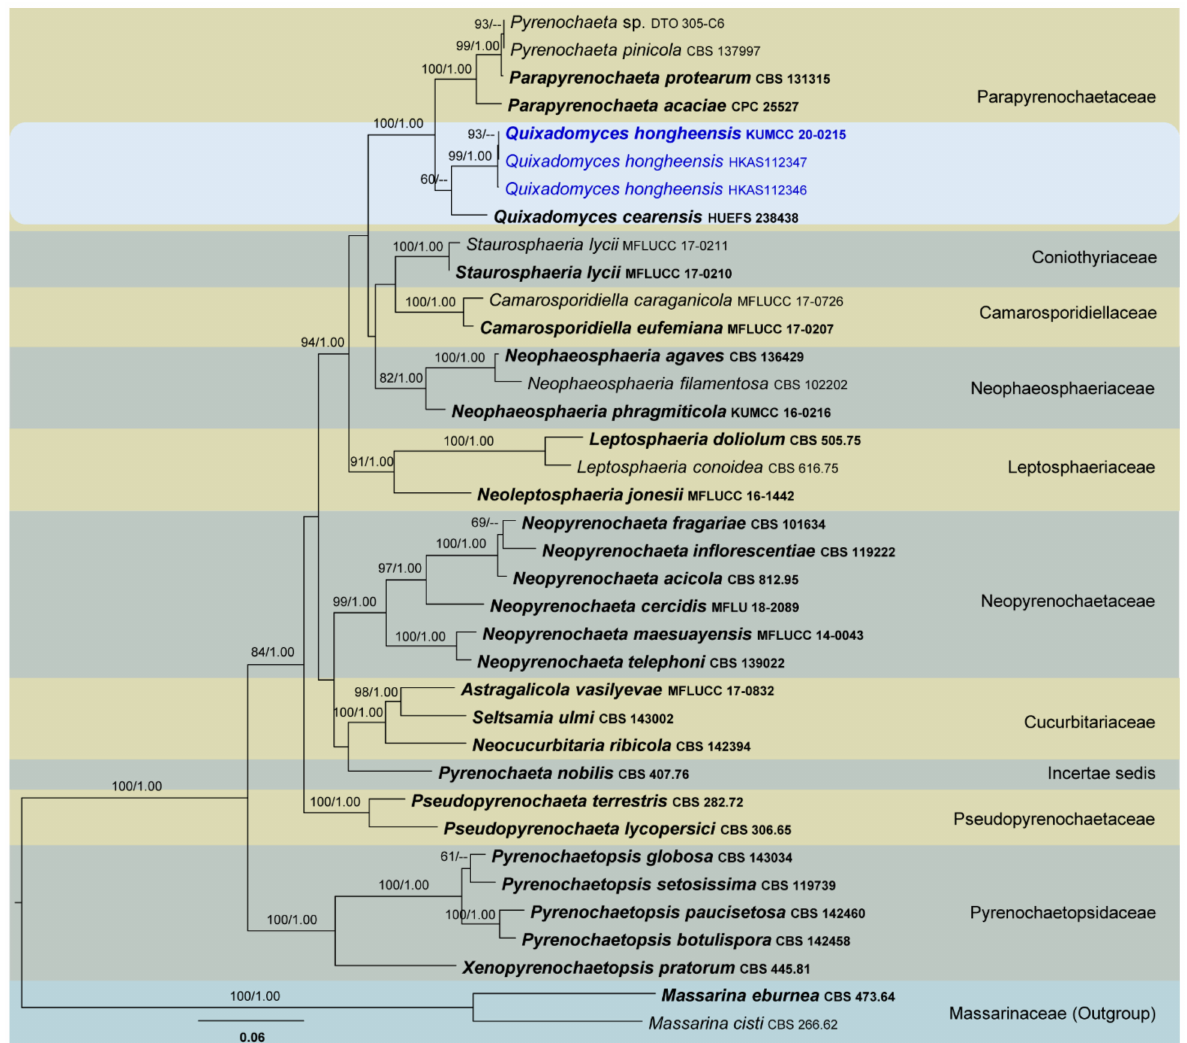
Figure 4. RAxML tree based on a combined dataset of partial LSU, SSU, ITS, rpb 2, tef 1 and btub DNA sequence analysis in Pleosporineae. The tree is rooted to Massarina cisti (CBS 266.62) and M . eburnea (CBS 473.64). Bootstrap support values for ML equal to or greater than 60% and BYPP equal to or greater than 0.95 are shown as ML/BI above the nodes. Known families and the genus Quixadomyces are indicated with coloured blocks. Blue represents new isolates. The ex-type strains are indicated in bold . The scale bar represents the expected number of nucleotide substitutions per